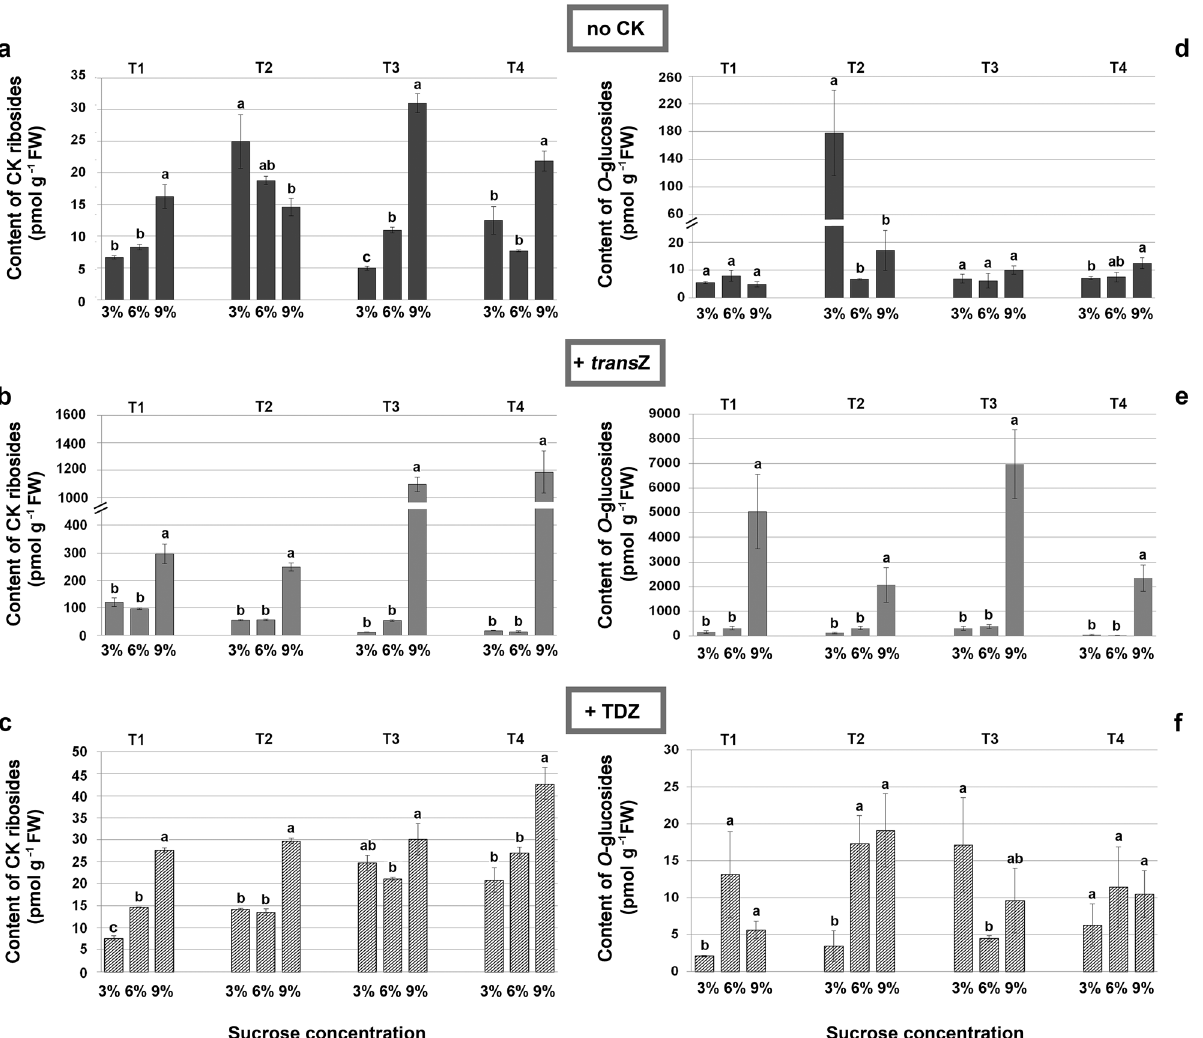
Figure 3. Contents (in pmol g −1 FW) of CK ribosides ( a – c ) and O -glucosides ( d – f ) in four developmental stages (T1–T4) during kohlrabi (cv. Vienna Purple) growth and de novo shoot organogenesis on media containing 3/6/9% sucrose without the presence of cytokinins ( a , d ), with 2 mg L −1 trans Z ( b , e ) or with 2 mg L −1 TDZ ( c , f ). Data are shown as the mean ± SE (n = 3 independent biological replicates). Means marked with the same letter within each developmental stage of each treatment were not significantly different according to the LSD post-hoc test, P ≤ 0.05. trans Z: trans -zeatin; TDZ: